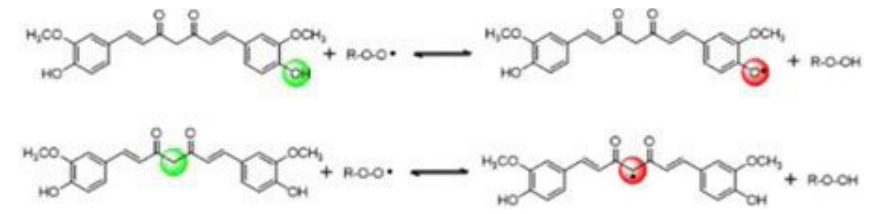
Figure 3. Curcumin action as an antioxidant and